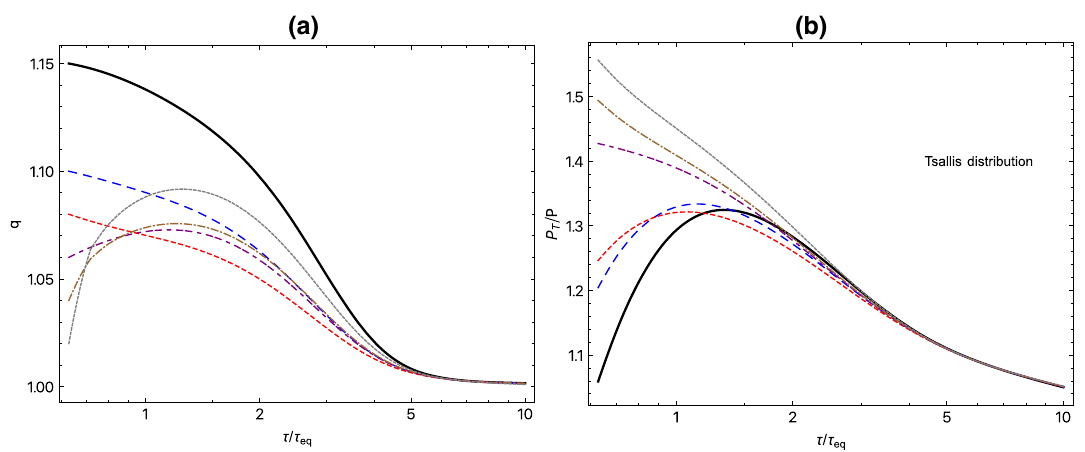
Fig. 5 Evolution of q and P T / P as a function of scaled timed τ/τ eq , left and right panels, respectively. Note that q 0 is different in each curve as can be seen from left panel whereas other initial conditions are the same as the ones used in Fig.